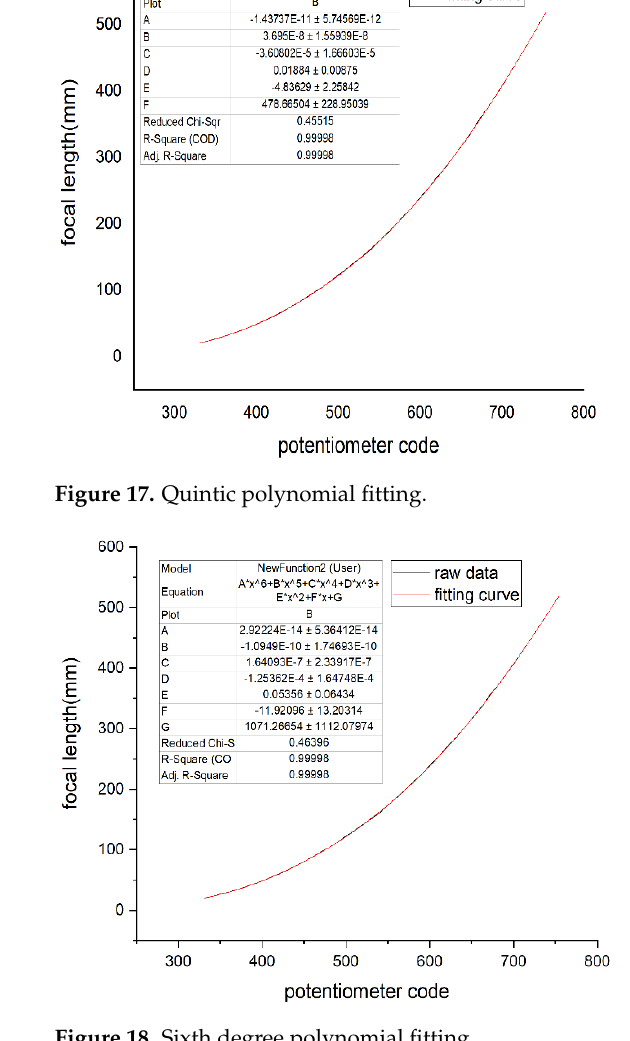
Figure 18. Sixth degree polynomial fitting.